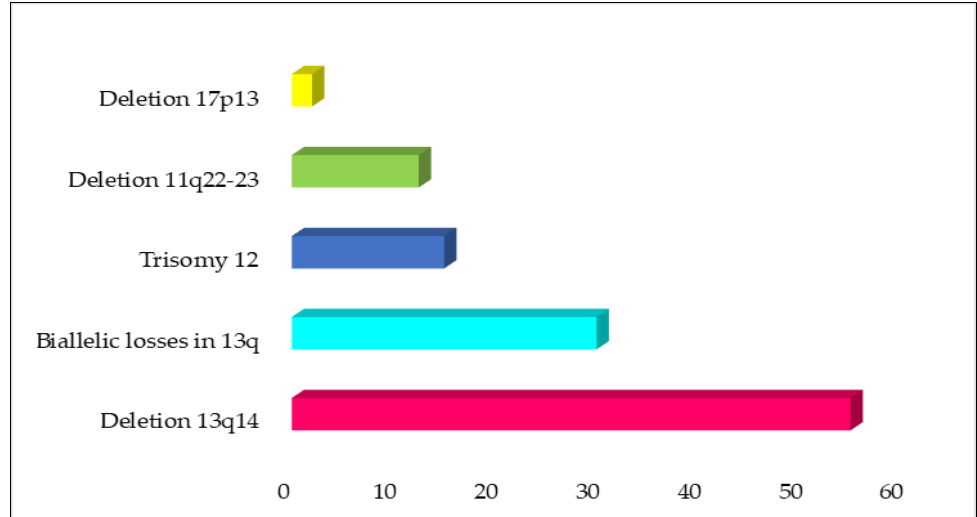
Figure 1. The common chromosomal abnormalities detected in CLL patients by FISH.